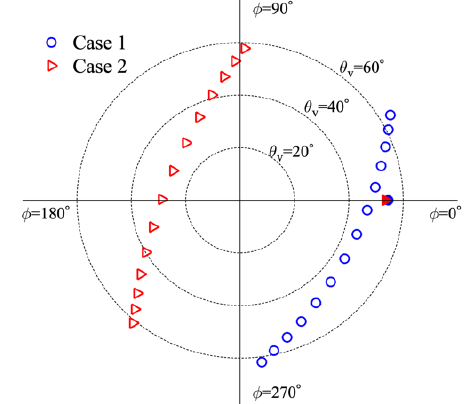
Figure 3. Multi-viewing observation geometries for forward simulations for 2 different cases. In which the solid circle and triangle with 𝜙 = 0° represent the corresponding position of the Sun for case 1 and case 2,